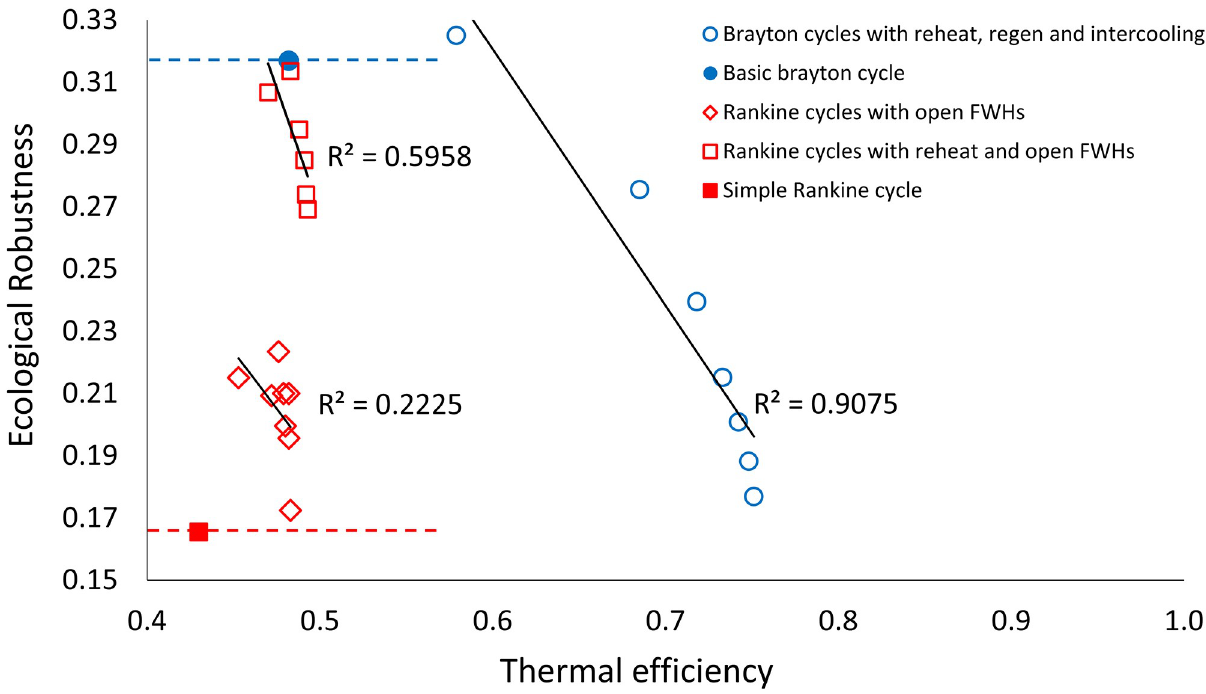
Fig 5. Thermal efficiency plotted against ecological robustness for the three sets of thermodynamic cycle improvements. The R values of the basic Brayton and Rankine cycles are highlighted by the red and blue dotted lines.